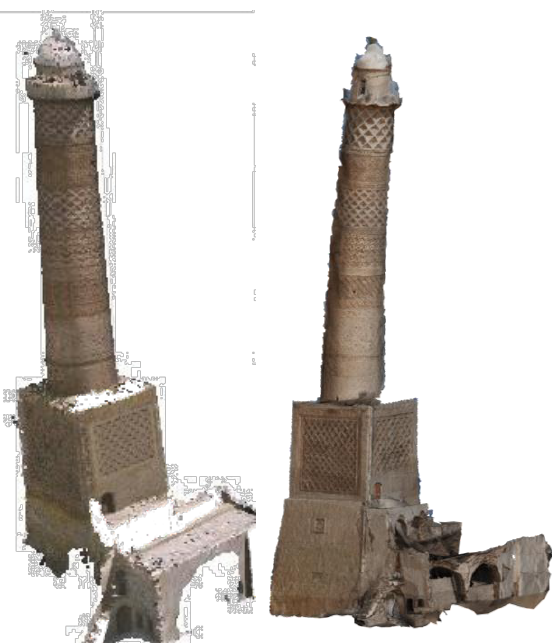
Figure 5. Metashape’s point cloud (left); and Meshroom’s point cloud (right).